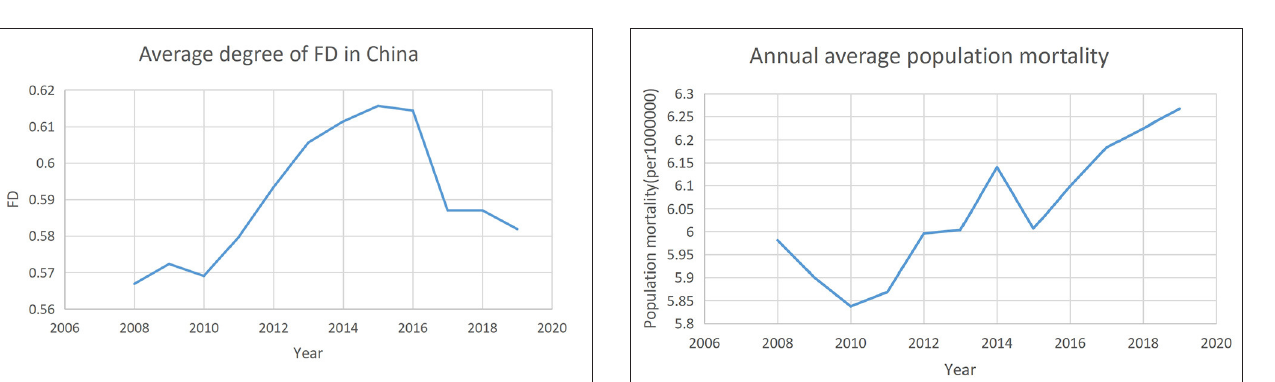
FIGURE 1 | Annual average degree of FD in the period of 2008–2019.